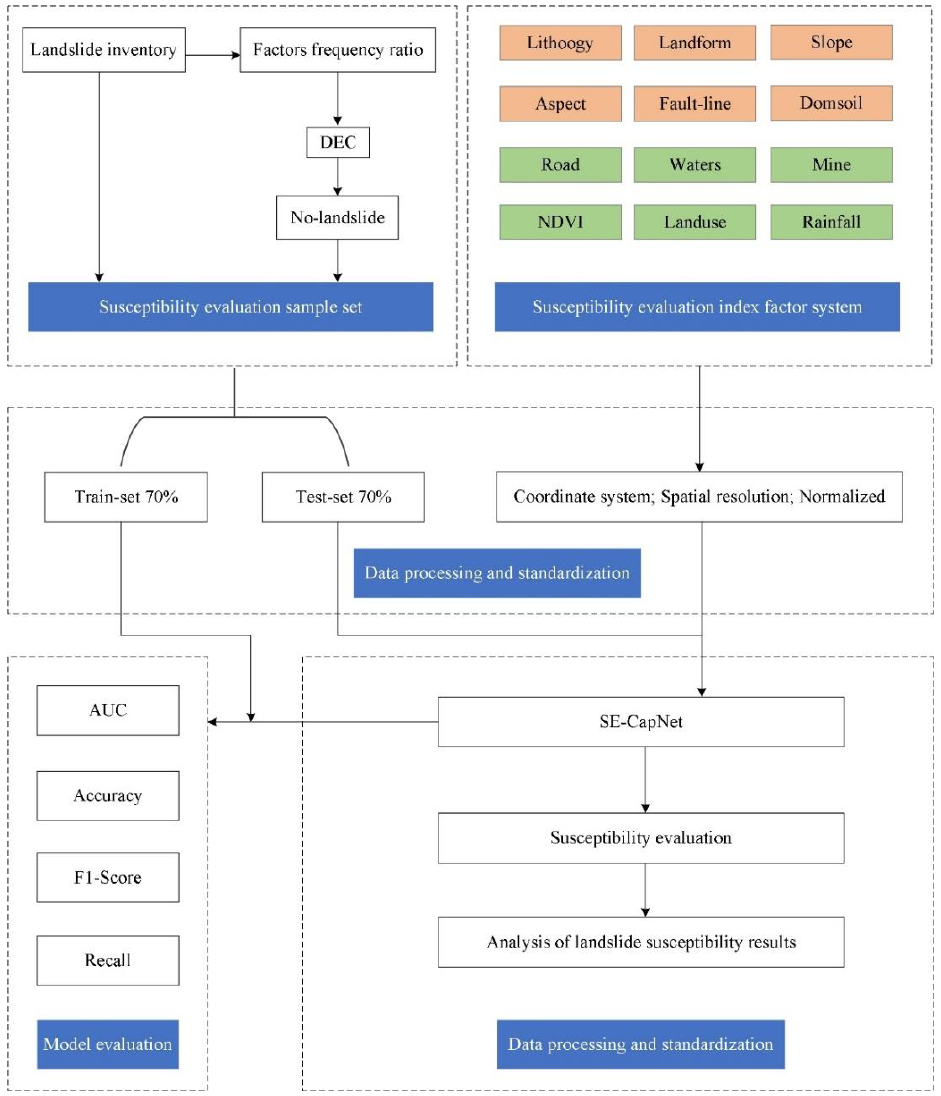
Figure 1. Technical Route.